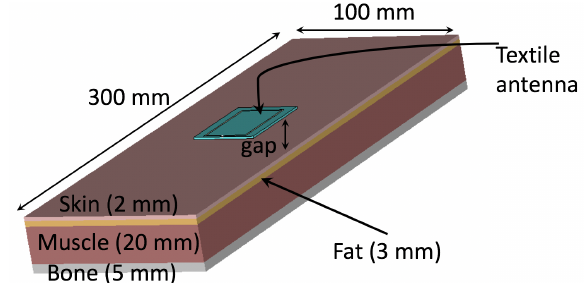
Figure 25. 3D view of numerical model to study performance of wearable loop antenna with and without HIS in close proximity to a human arm. Note that wearable loop antenna alone (without HIS structure) is shown only.